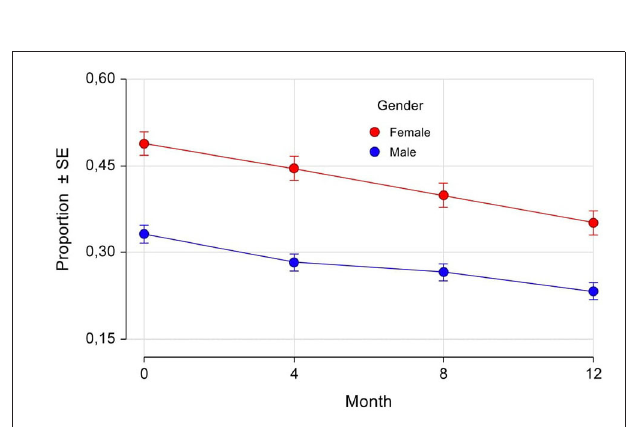
FIGURE 5 | Dyskinesia: Proportion of patients by gender and visits. SE, Standard Error.